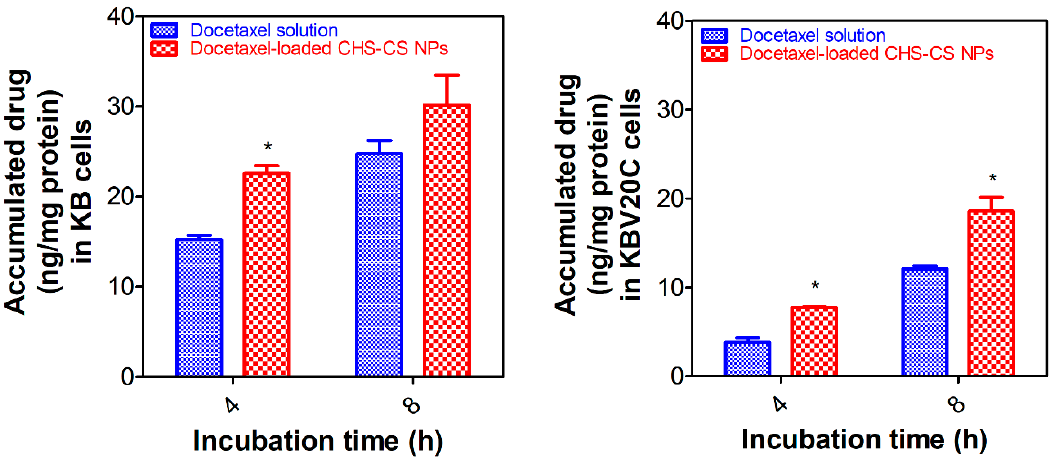
Figure 7. Cellular accumulation assays of designed NPs in KB and KBV20C cells. Incubation time-dependent cellular accumulated amounts of docetaxel in docetaxel solution and docetaxel-loaded CHS-CS NPs-treated groups in KB and KBV20C cells. Each point represents mean ± S.D. ( n = 3). * p < 0.05.